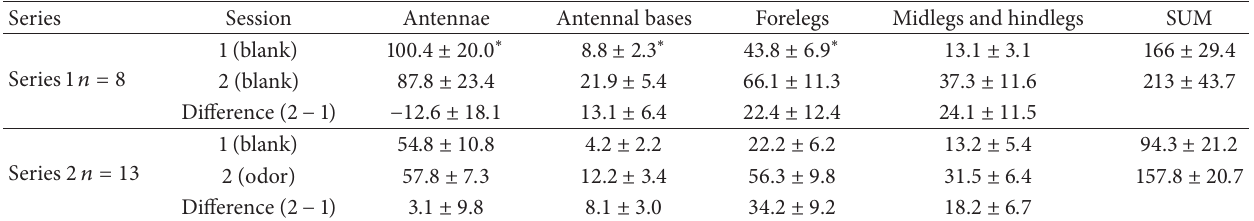
Table 3: Time spent for grooming (s). Mean ± Standard error. Difference was calculated for each animal.